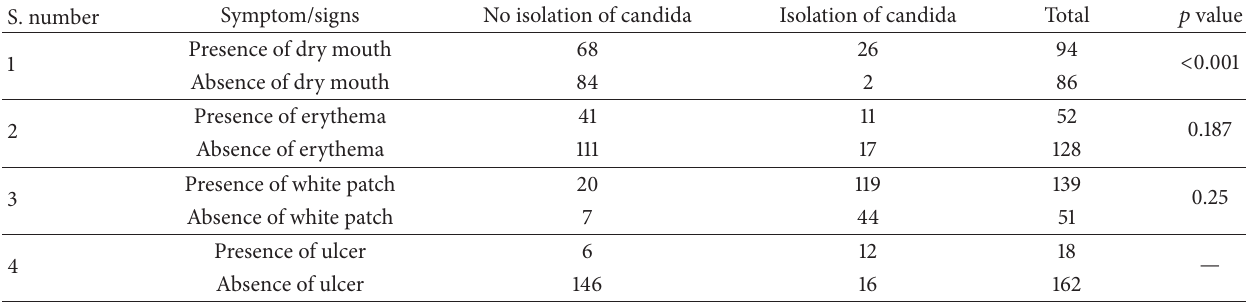
Table 2: Mycological and clinical association between the symptoms/signs.